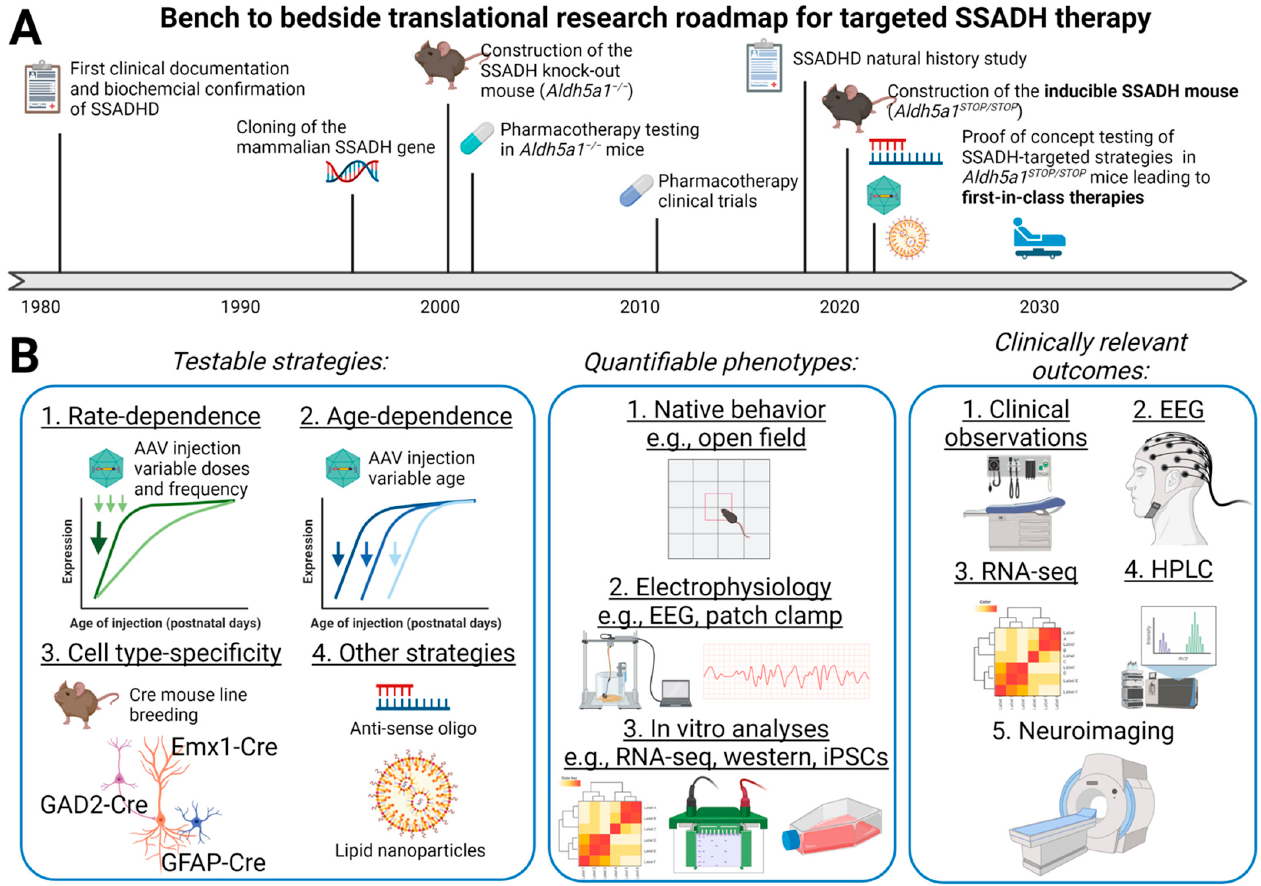
Figure 1. Translational roadmap of bench to bedside discovery and development of SSADH-targeted medicine. ( A ) A brief timeline of SSADH research from initial discovery to potential first-in-class SSADH-restoring therapies development. Originally documented and confirmed biochemically in the early 1980 ′ s, there are important landmarks including cloning of the ALDH5A1 gene, construction of the first mouse model aldh5a1 −/− , quickly followed by a barrage of pharmacotherapy testing from preclinical to clinical settings. The recent launch of the SSADHD Natural History Study and the ongoing construction work of the novel SSADHD mouse model aldh5a1 STOP/STOP are instrumental to accelerate bench to bedside translational research for SSADHD. ( B ) SSADH-restoring strategies are readily testable using the aldh5a1 STOP/STOP mice. Key strategies include: (1) rate-dependence, (2) age-dependence, and (3) cell type-specificity. In addition, other novel strategies such as anti-sense oligonucleotide or lipid nanoparticles delivery approach can be tested. The aldh5a1 STOP/STOP will be an in vivo platform allowing quantifiable assessment of phenotype reversal, from behavior to the molecular level. Relevant preclinical results will combine with the Natural History Study to form the basis for prognostic assessment in eventual clinical